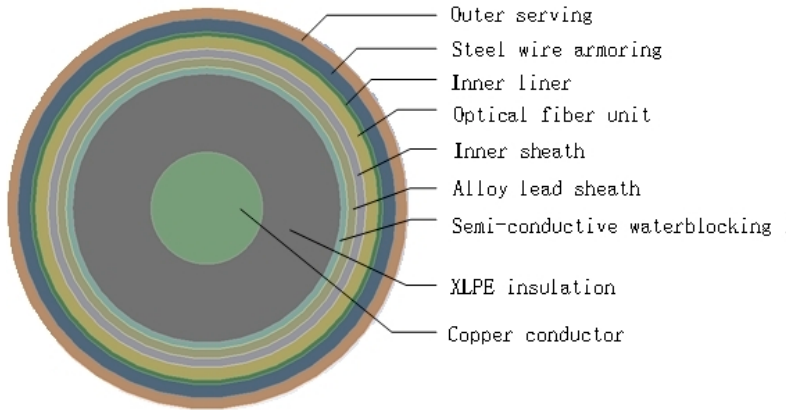
Figure 2. Simplified model structure of the submarine cable.